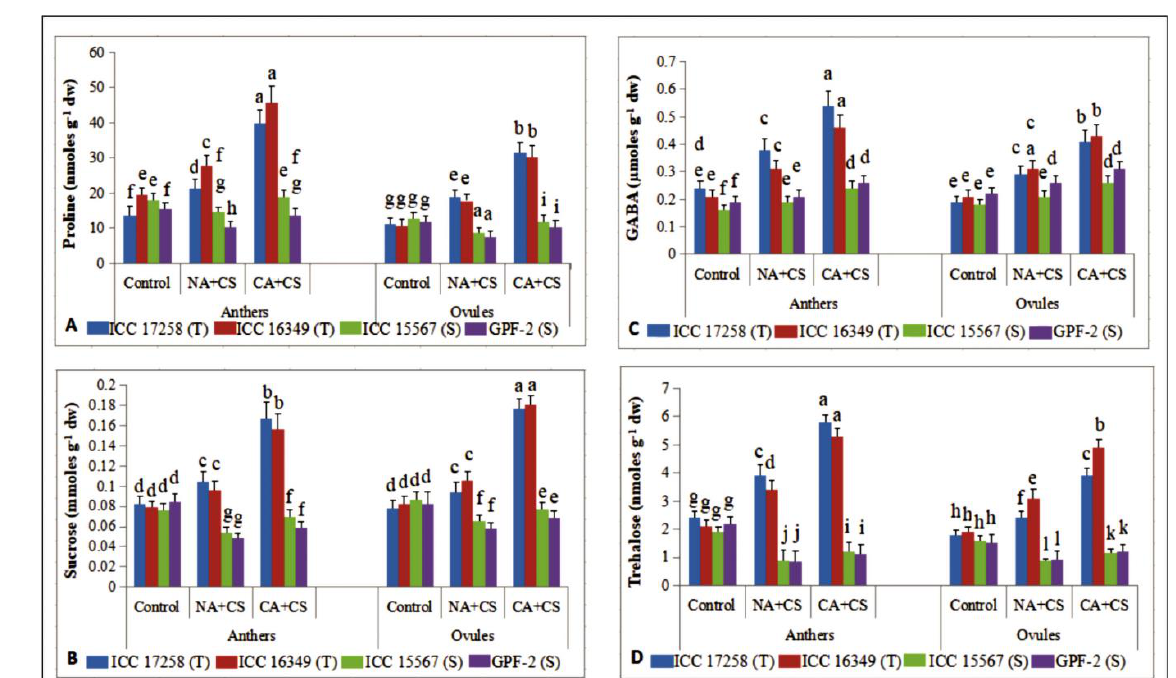
Figure 9. Proline (Pro; ( A )), Sucrose (Suc; ( B )), γ-amino butyric acid (GABA; ( C )) and trehalose (Tre; ( D )) in anthers and ovules of control, non-acclimated, cold stressed; NA + CS) and cold-acclimated, cold stressed (CA + CS) plants of tolerant (T) and sensitive (S) genotypes. Small vertical bars represent standard errors (Mean ± S.E; n = 3). Different small letters on vertical bars indicate significant differences from each other ( p < 0.05; Tukey’s test). Least significant difference (LSD) for interaction ( p < 0.05) (genotypes x treatments): Pro (3.9), GABA (0.048), Suc (0.009), Tre (0.40).